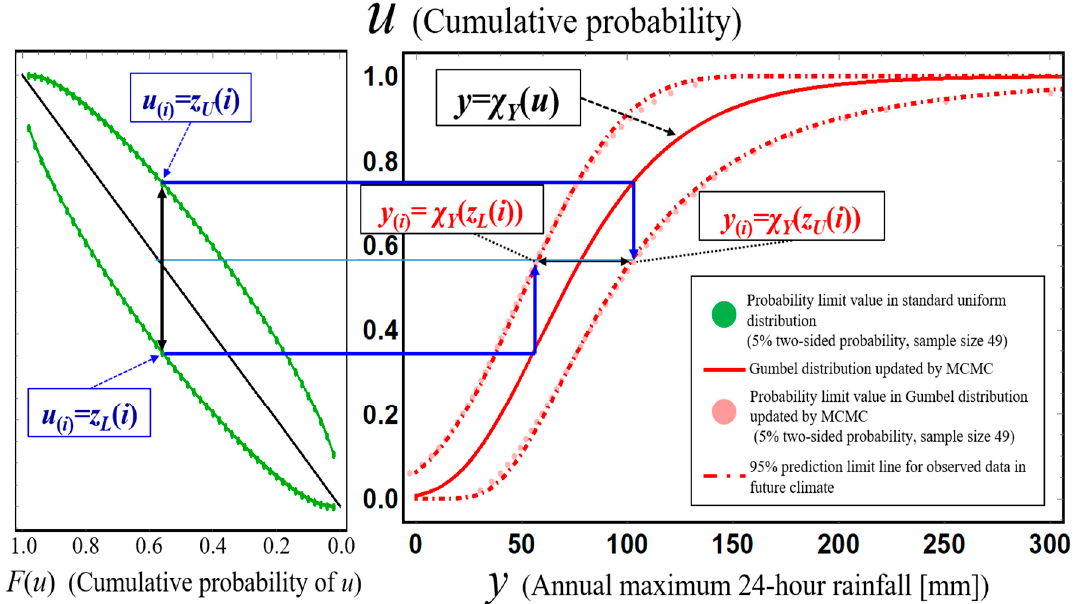
Figure 21. Construction process of 95% prediction interval based on probability limit method test for future climate. y is the probability variable expressing future extremes.